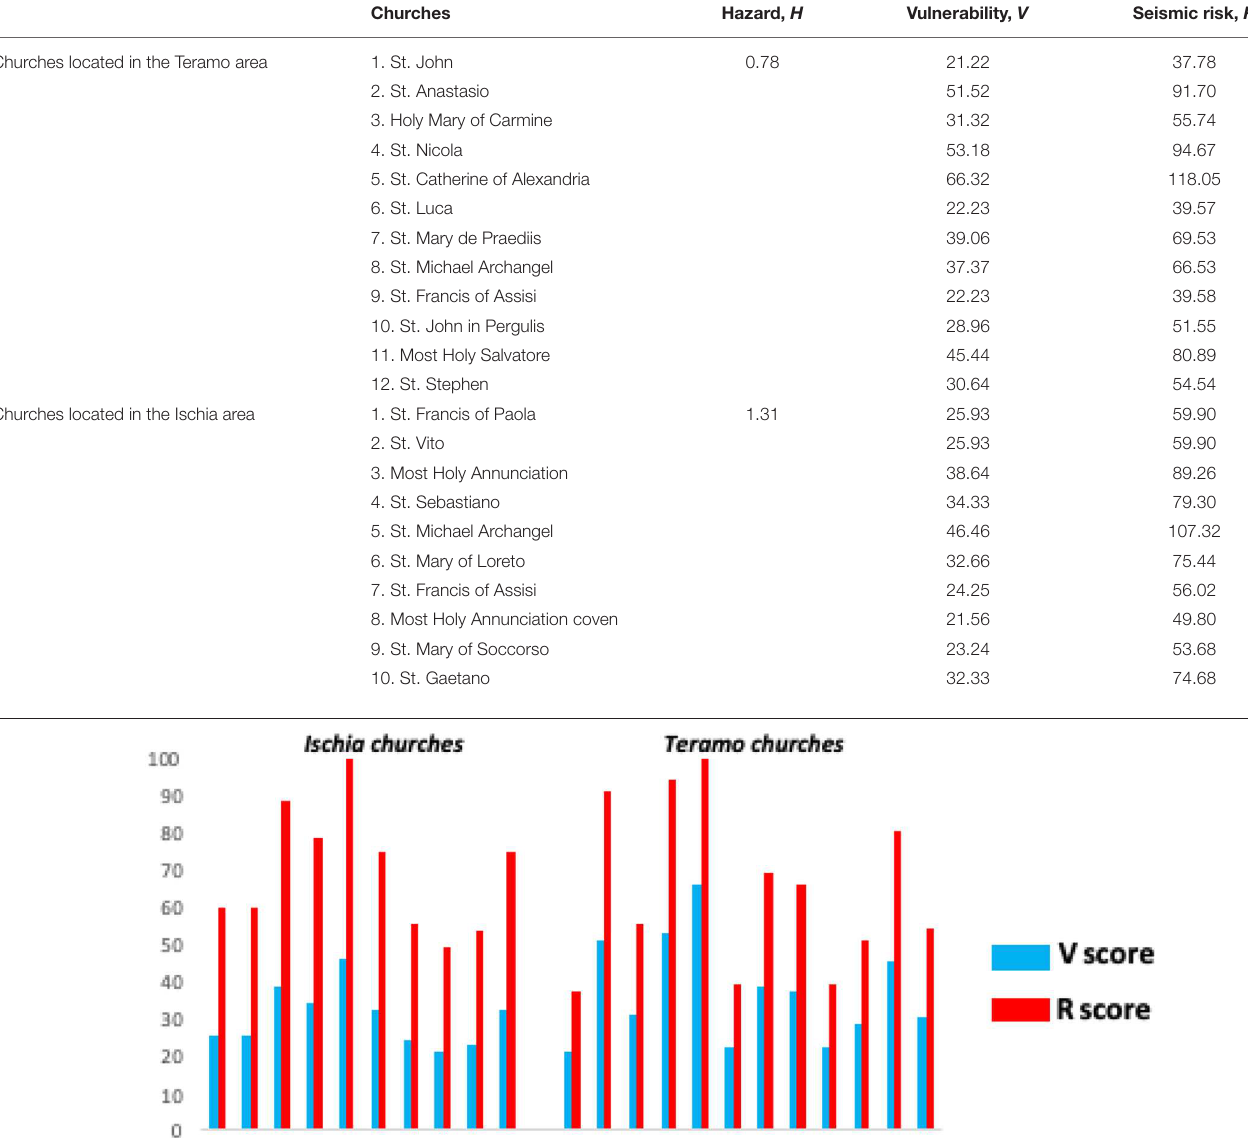
TABLE 8 | Seismic risk evaluation.